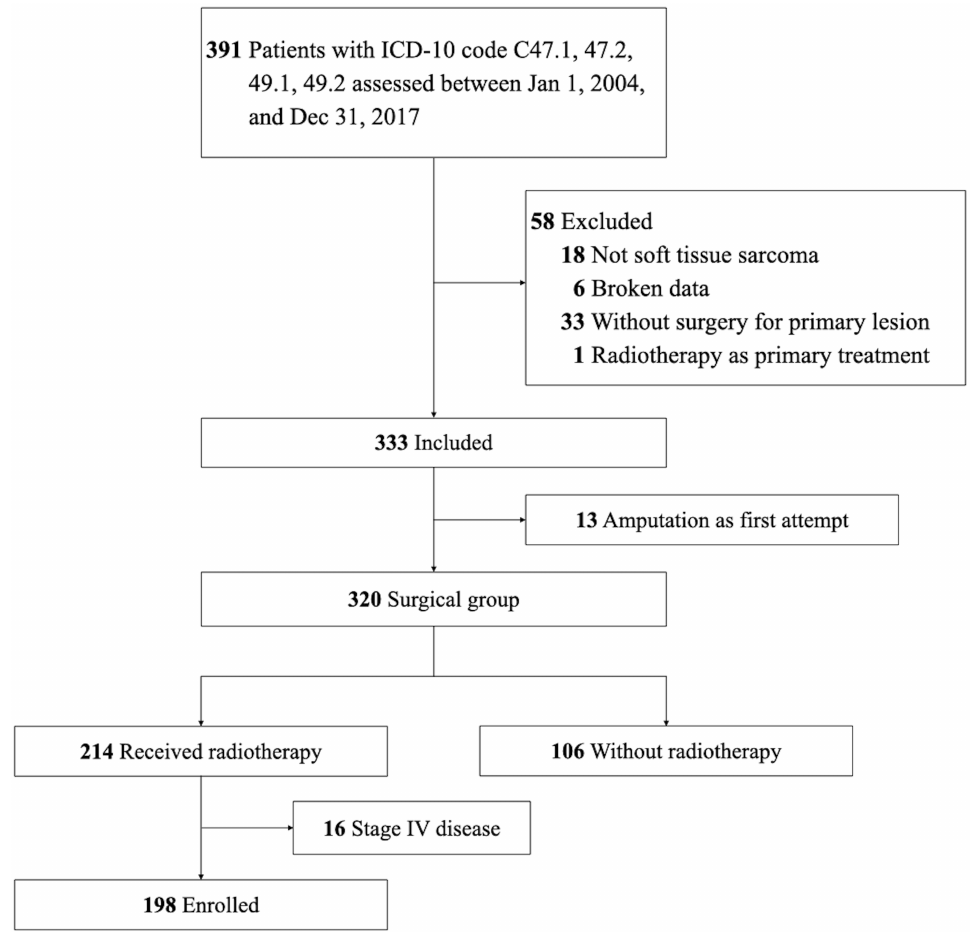
Figure 1. Flowchart of the selection and grouping of patients with extremity